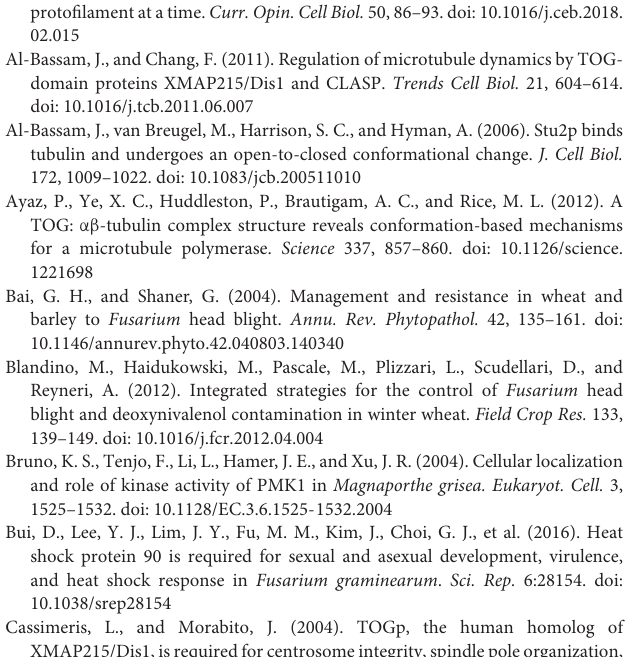
Supplementary Figure 3 | Sequences alignment of budding yeast Ndc80 and presumed Fg Ndc80. Amino acid sequences (budding yeast Ndc80 protein ID: NP_012122.3; Fg Ndc80 protein ID: XP_011328506.1) alignment was performed using the online service (www.genome.jp/tools-bin/clustalw). The alignment images were generated by the online service of ESPript 3.0 (espript.ibcp.fr/ESPript/cgi-bin/ESPript.cgi). Supplementary Figure 4 | Construction of the Fg Stu2-3 × FLAG strain. (A) Schematic of vector construction. (B) Polymerase chain reaction (PCR) identification of Fg Stu2-3 × FLAG strains. a 1.8 kb fragment was amplified by primers P29/P30 indicates that 3 × FLAG-G418 fragment was successfully inserted at 3 (cid:48) -terminal of Fg Stu2 coding sequence. Supplementary Figure 5 | Construction of the Fg γ -tubulin-EGFP and Fg Ndc80-EGFP strains. (A) Schematic of vector construction. (B) Polymerase chain reaction (PCR) identification of Fg γ -tubulin-EGFP and Fg Ndc80-EGFP strains. a 2.7 kb fragment was amplified by primers P35/P36 indicates that the EGFP-HPH fragment was successfully inserted at 3 (cid:48) -terminal of Fg γ -tubulin coding sequence. a 2.7 kb fragment was amplified by primers P41/P42 indicates that the EGFP-HPH fragment was successfully inserted at 3 (cid:48) -terminal of presumed Fg Ndc80 coding sequence. Supplementary Figure 6 | MBC Sensitivity of wild-type strain PH-1, Fg β 2F167Y, and FgStu2-Si mutants. (A) MBC Sensitivity of wild-type strain PH-1 and Fg Stu2-Si-1 on PDA plates with or without 30 µ M zearalenone (ZEA). (B) MBC Sensitivity of Fg β 2F167Y and F167Y-Stu2-Si on PDA plates with or without 30 µ M ZEA. Plugs were transferred from the margins of 3-day old PDA colonies to fresh PDA plants containing different concentrations of MBC. The timing for photography was based on the growth rates of each strain. Supplementary Table 1 | Primers used in this